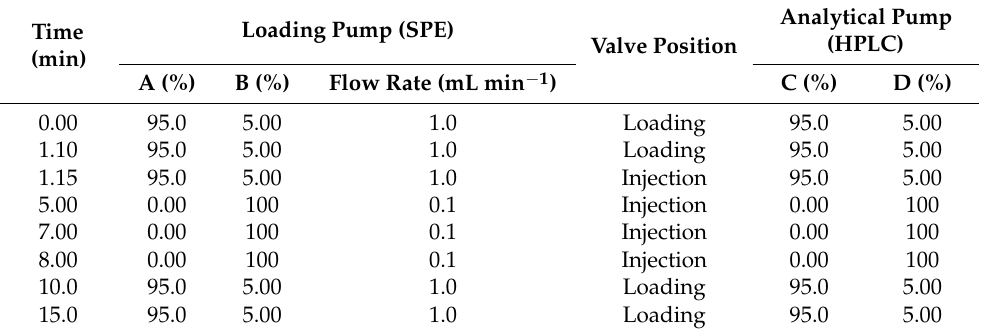
Table 1. Mobile phase program for the loading and analytical pumps (A = 0.1% ( v / v ) formic acid in water, B = methanol, C = 0.1% ( v / v ) formic acid in water, and D = 0.1% ( v / v ) formic acid in acetonitrile).